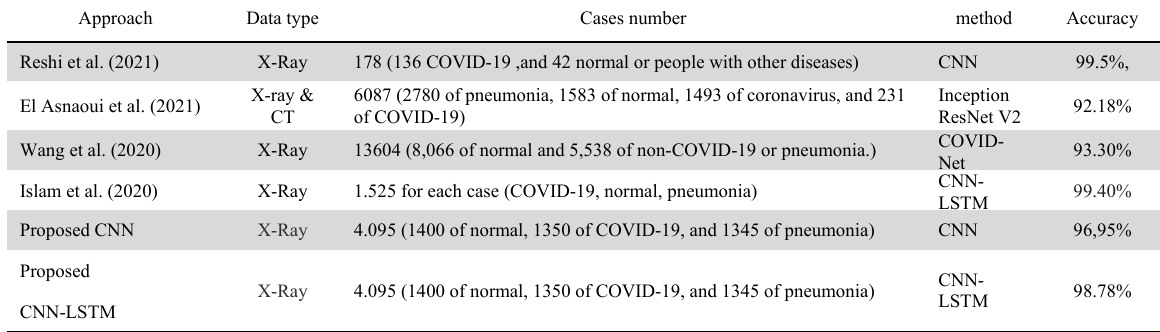
Comparison results of the proposed methods with the other deep learning methods on COVID-19 diagnosis Approach Data type Cases number method